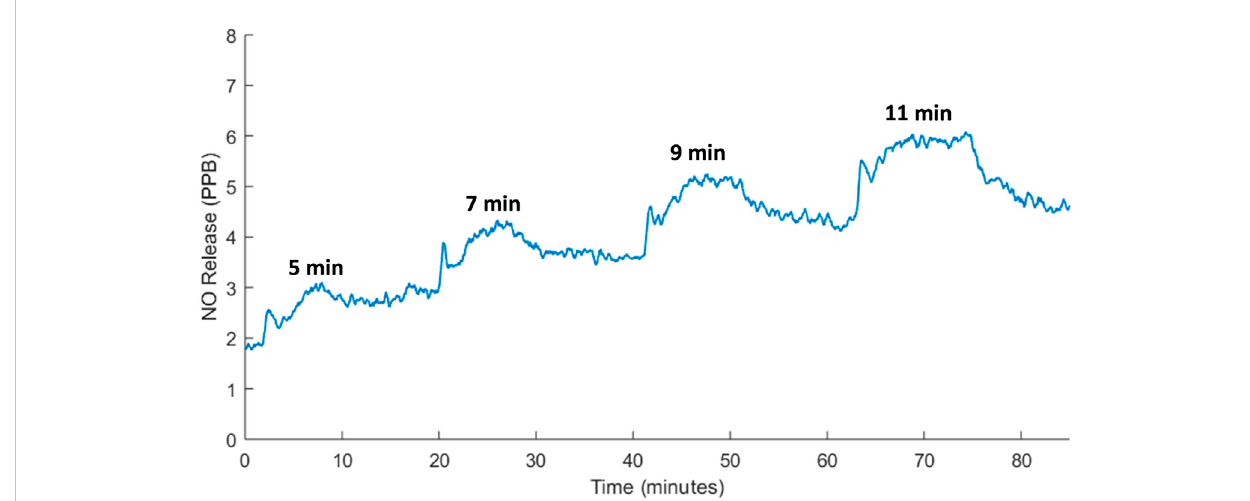
FIGURE 13 Real-time NO release from SF hydrogels with 5 – 11 min of FUS heating at 40 ° C and 12-min cooling intervals showing tight temporal control over remote NO delivery. Hydrogel warming was achieved with a peak acoustic pressure of ±5.8 MPa and maintenance at 40 ° C was obtained with a peak acoustic pressure of ±3 MPa.